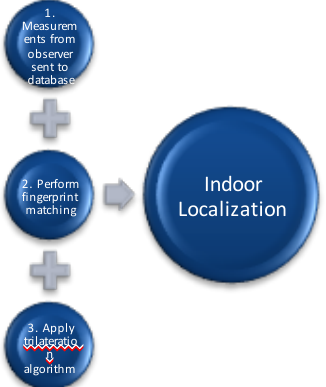
Figure 1 – Steps performed to compute a user’s